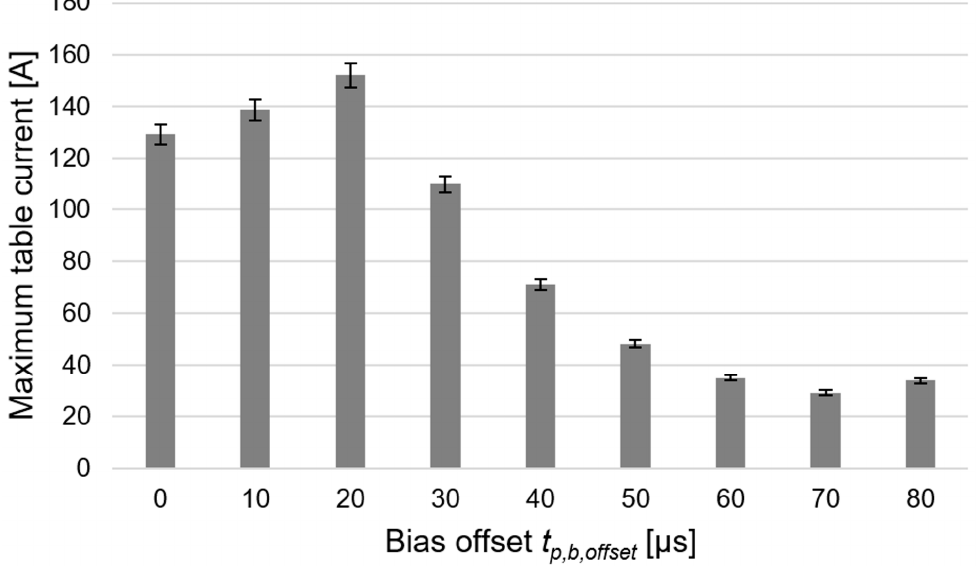
Figure 3. Results of bias offset at 150Ar0Kr, 500 Hz, a cathode on-time of 20 µs and a bias on-time of 50 µs.